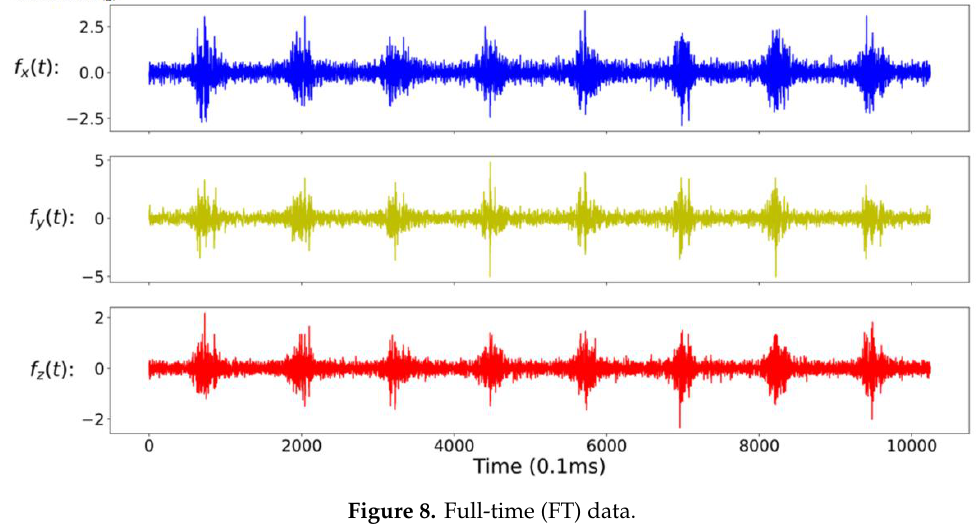
Figure 7. Schematic diagram of composite fault vibration data capture.